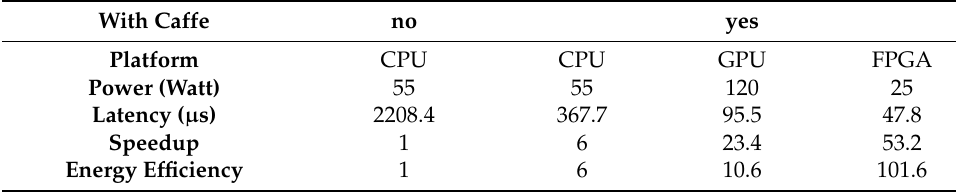
Table 4. Comparison among different